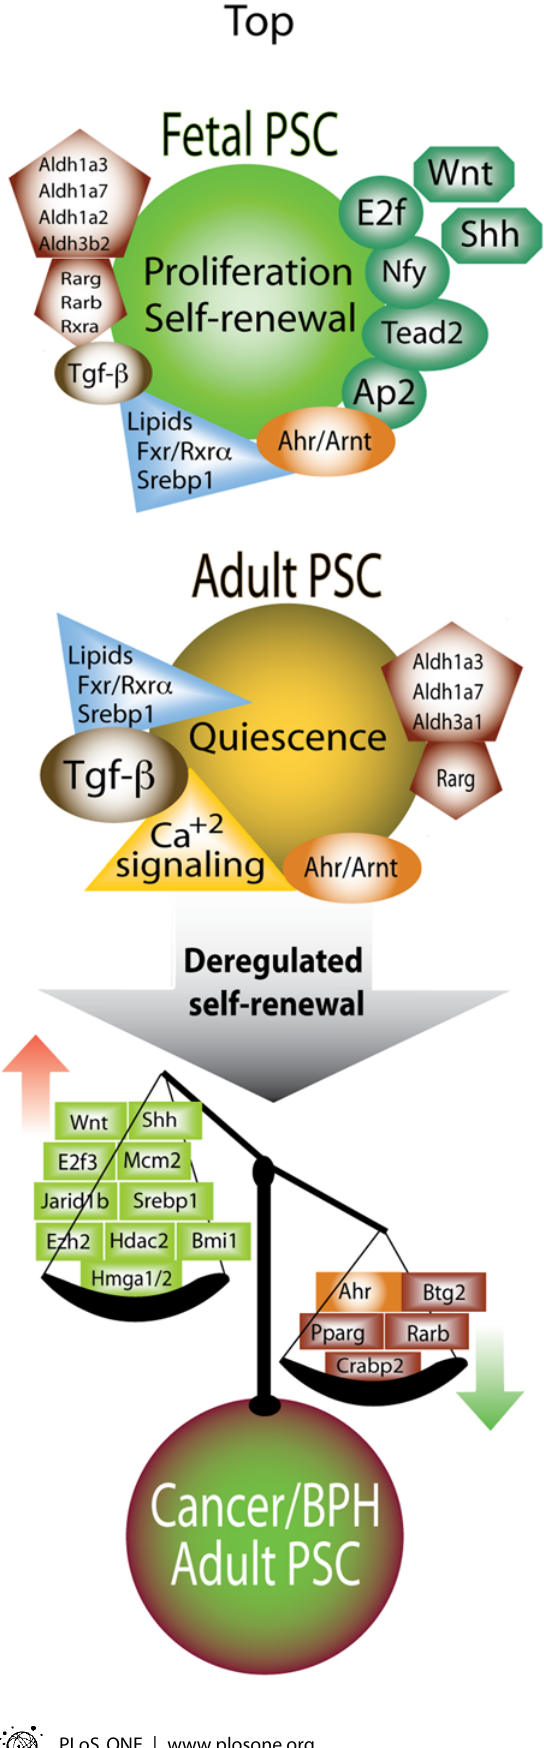
Figure 4. A model of the profiles of fetal PSC and adult PSC indicating commonalities and differences and the manner by which these may alter in proliferative prostatic diseases. Common and distinctive signaling pathways as well as molecules participating in the regulation of self-renewal in fetal PSC and in quiescence in adult PSC were revealed by our gene profiling studies. The unbalanced scales represent possible perturbations in adult PSC that result in the overexpression of certain proto-oncogenes that promote SC self-renewal while other elements that promote differen- tiation are suppressed, thus leading to deregulated growth. The indicated candidate genes were detected as PSC-related genes that are aberrantly expressed in prostate tumors. Their expression may contribute to the etiology of abnormal PSC proliferation leading to escape from dormancy and unrestrained self-renewal culminating in benign prostate hyperplasia or prostate tumors.